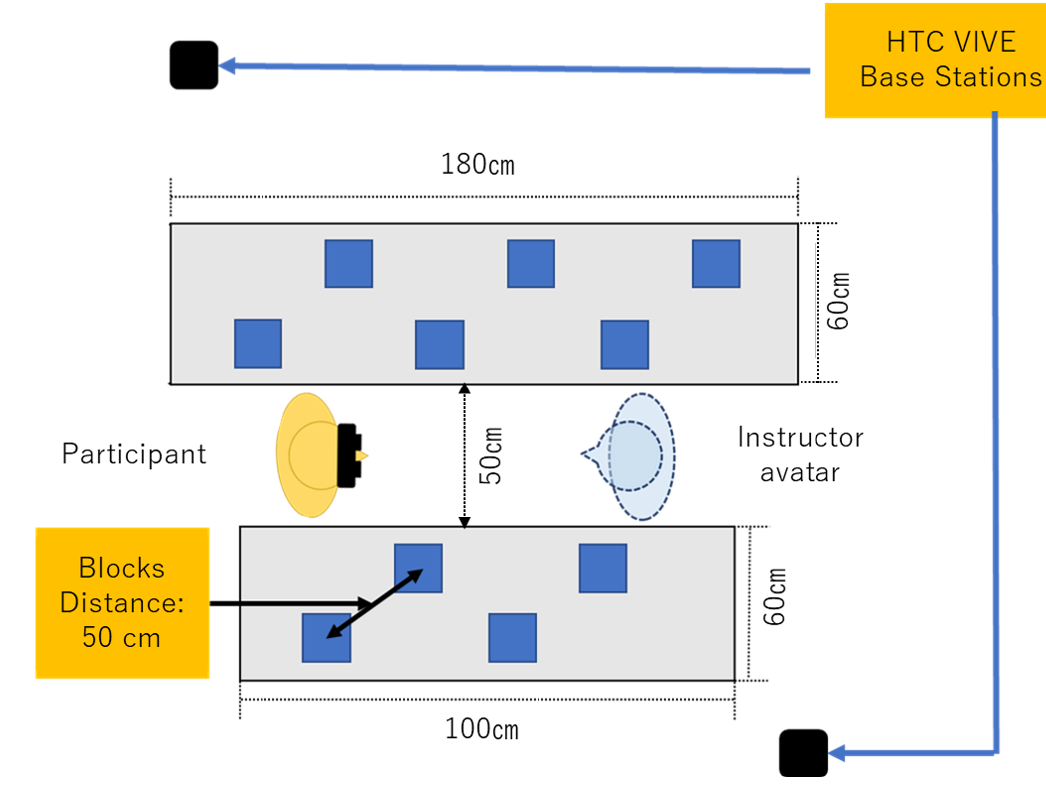
Figure 2. Experimental